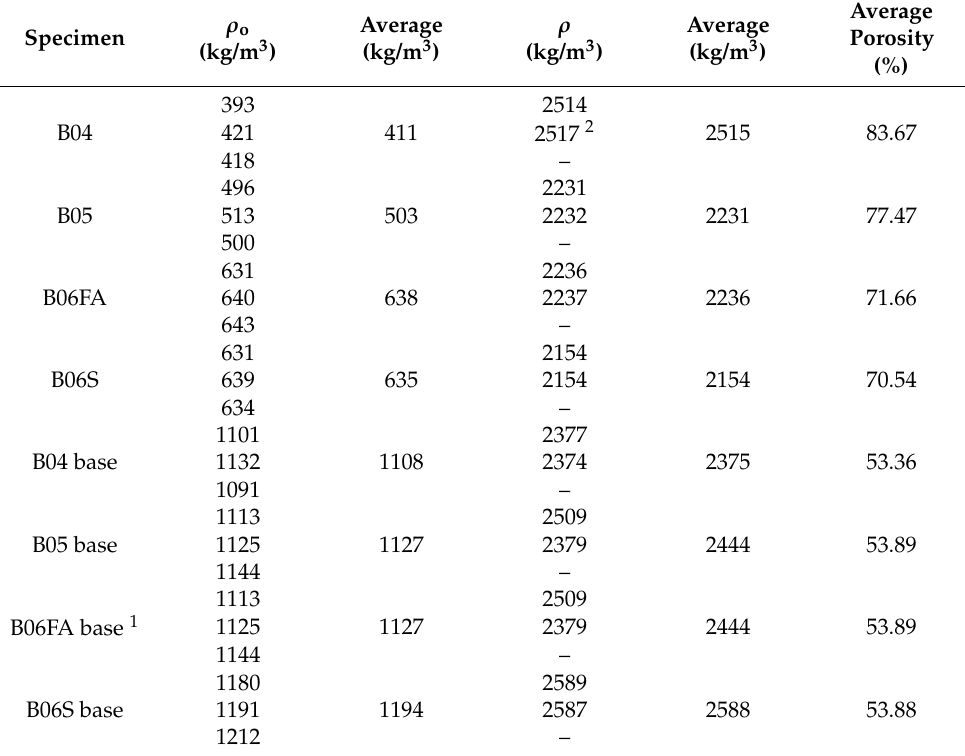
Table 6. Test results of porosity of AAC and base